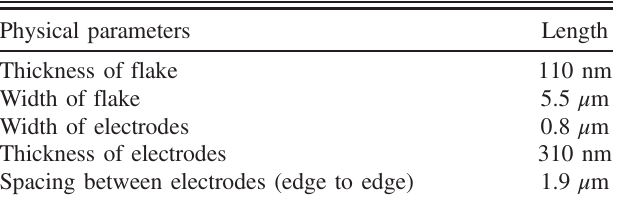
TABLE I. Sample dimensions. These parameters are used in numerical